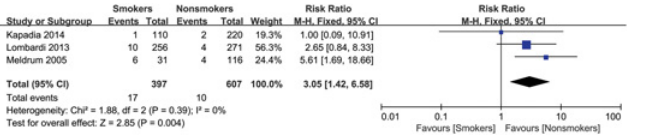
Fig 2. Forest plot of the association between smoking and the risk of aseptic loosening of prosthesis after total hip arthroplasty.